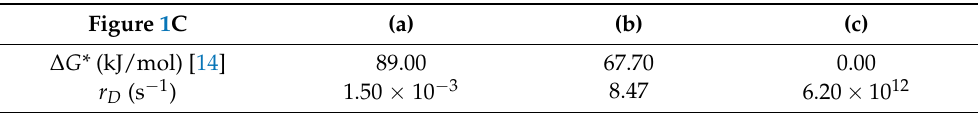
Table 3. Atomistic activation energy ( ∆ G* ) [14] and the calculated atomistic forward reaction rates ( r D ) for the Si-C dissolution on the (100) and (100) facets for 3 different event scenarios applied in case 3. Si-C dissolution (Figure 1C): (a) in the presence of Si1 and Si2; (b) in the presence of Si1 or Si2; and (c) in the absence of both Si1 and